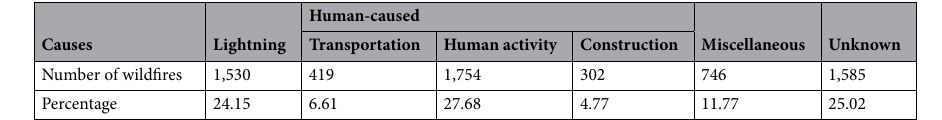
Table 3. Statistical summary of wildfire ignition causes in CA from 2000 to 2019.